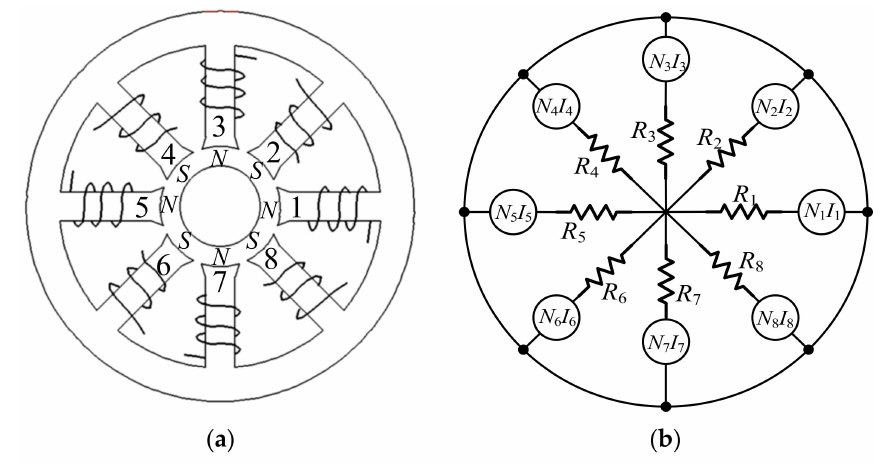
Figure 3. Eight-pole bearing arrangement ( a ) and equivalent magnetic circuit ( b